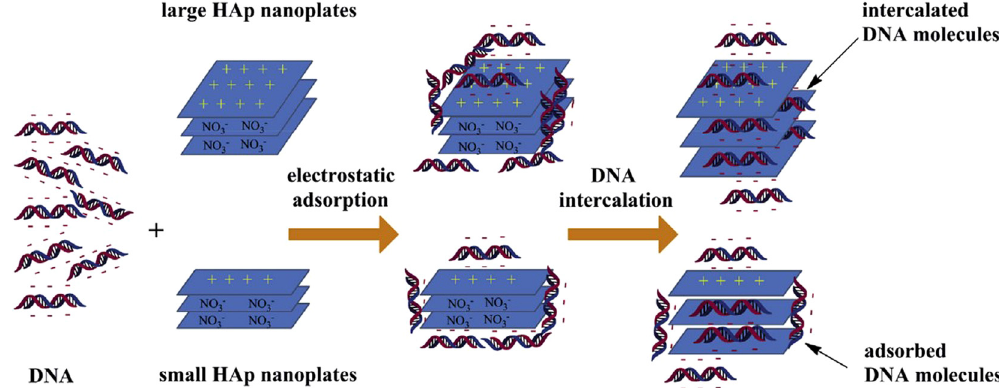
Figure 4: Schematic illustration of the loading process of DNA molecules to L - HA nanoplates [ 54 ]